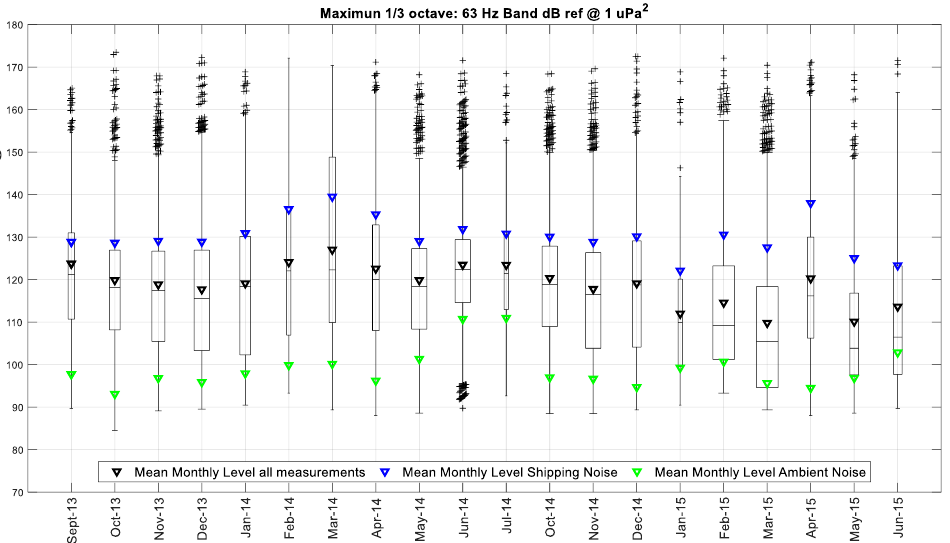
Figure 7. Monthly average evolution of the maximum of the 1/3 octave band at 63 Hz of all measurements. The mean monthly values of shipping, other anthropogenic, and natural noise measurements are represented with blue, black, and green triangles, respectively.